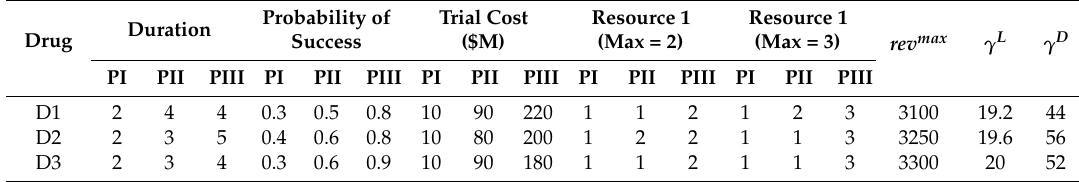
Table A2. Parameters of the three-drug case study.